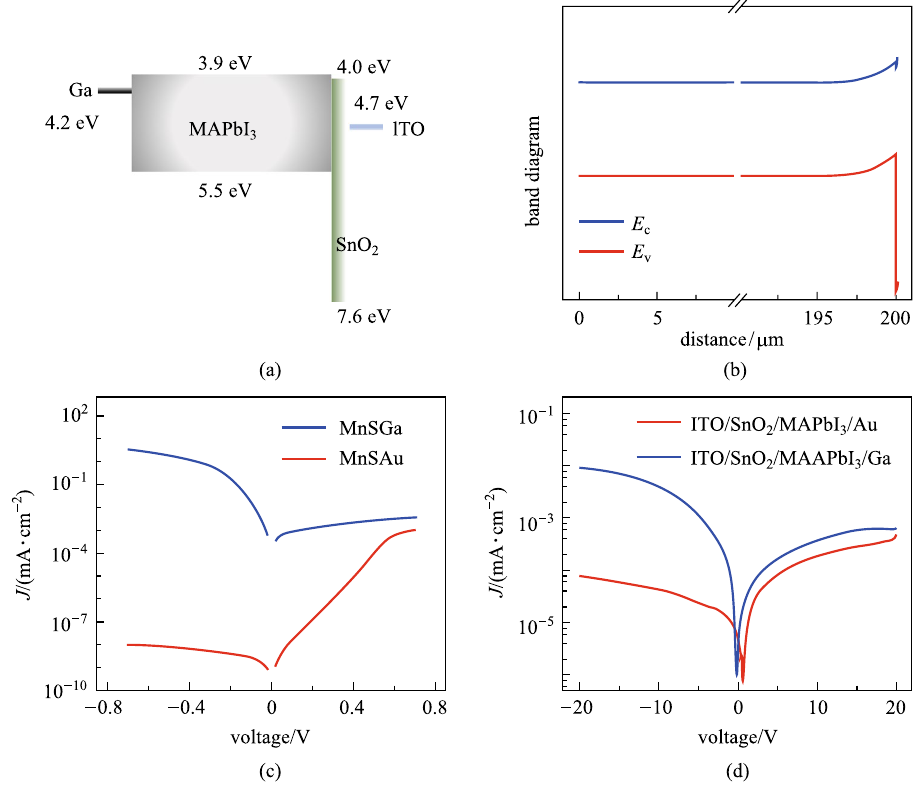
Fig. 4 Simulated and experimental characteristics of Schottky devices. a Band diagram of the junction device with Ga electrode. b Simulated energy band of the junction device with Ga electrode. Comparison of the c simulated and d experimental J – V curves with Au and Ga metal